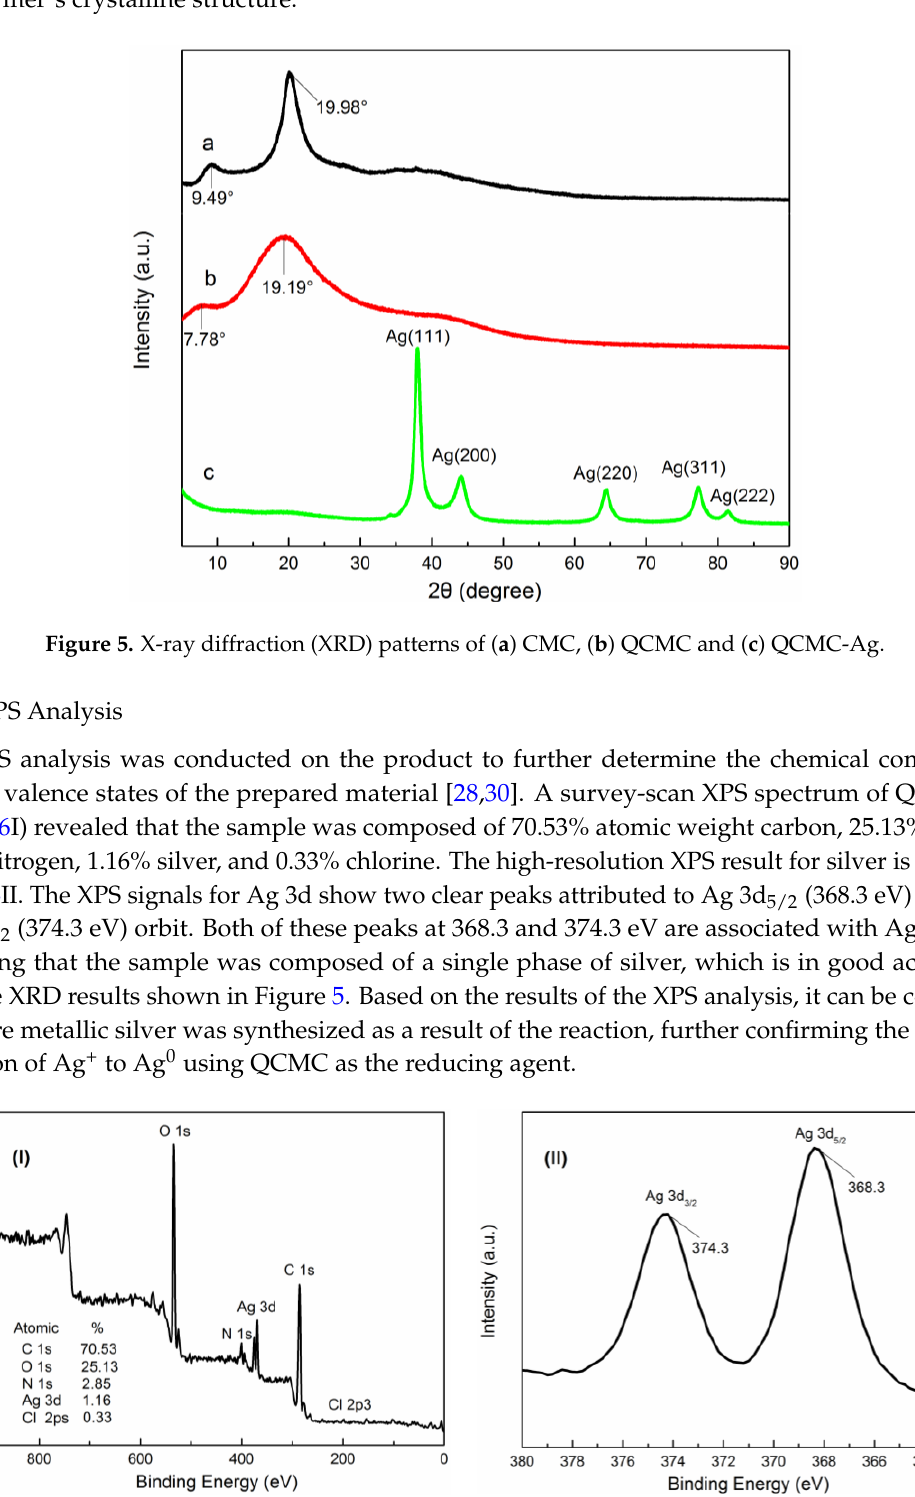
Figure 6. X-ray photoelectron spectroscopy (XPS) spectra of as-prepared QCMC-Ag. ( I ): Survey-scan spectrum. ( II ): High-resolution Ag 3d spectrum.